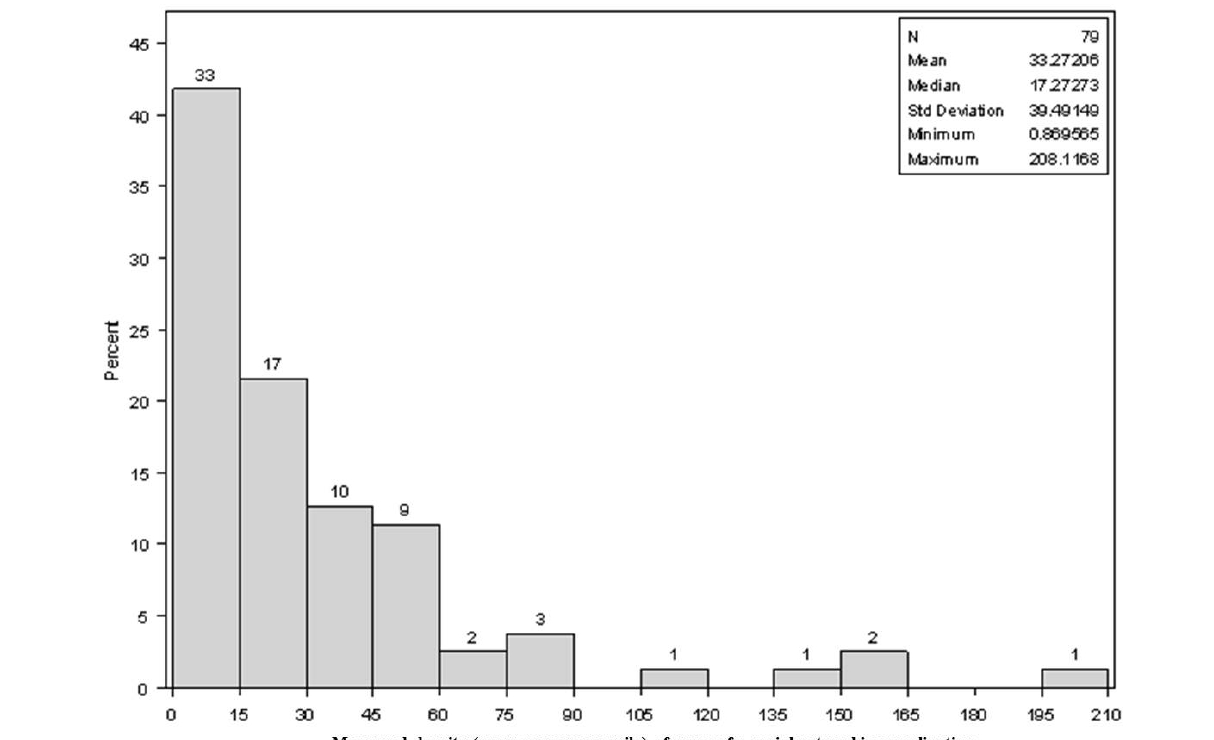
Figure 5. Histogram showing distribution of observed density of social network application users per 1-mile circle for the 79 sampled locations in Atlanta (inset includes statistics for the distribution, which is highly skewed with SD estimated to be larger than the mean; numbers above bars are the number of sample points with density along the X axis and the Y axis representing the percent of all points with this